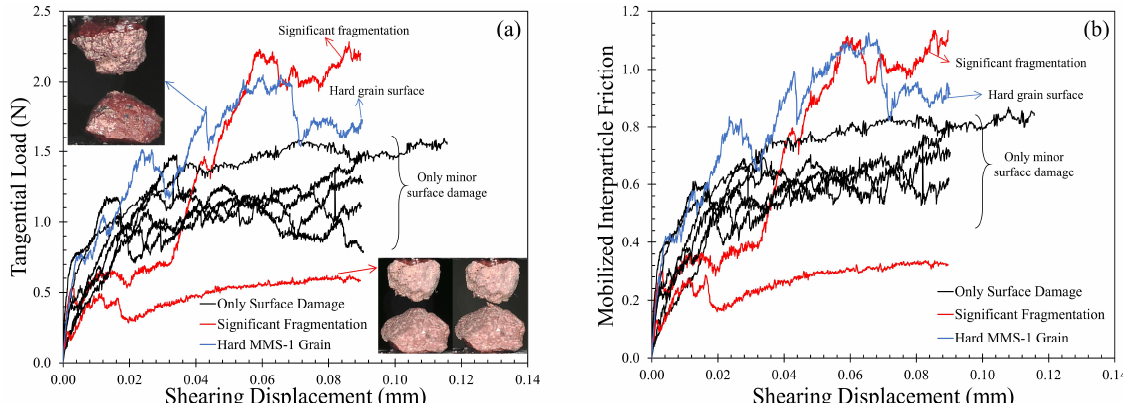
Figure 6. Tangential contact response of MMS-1 grains, ( a ) tangential load and ( b ) mobilized interparticle friction against shearing displacement.